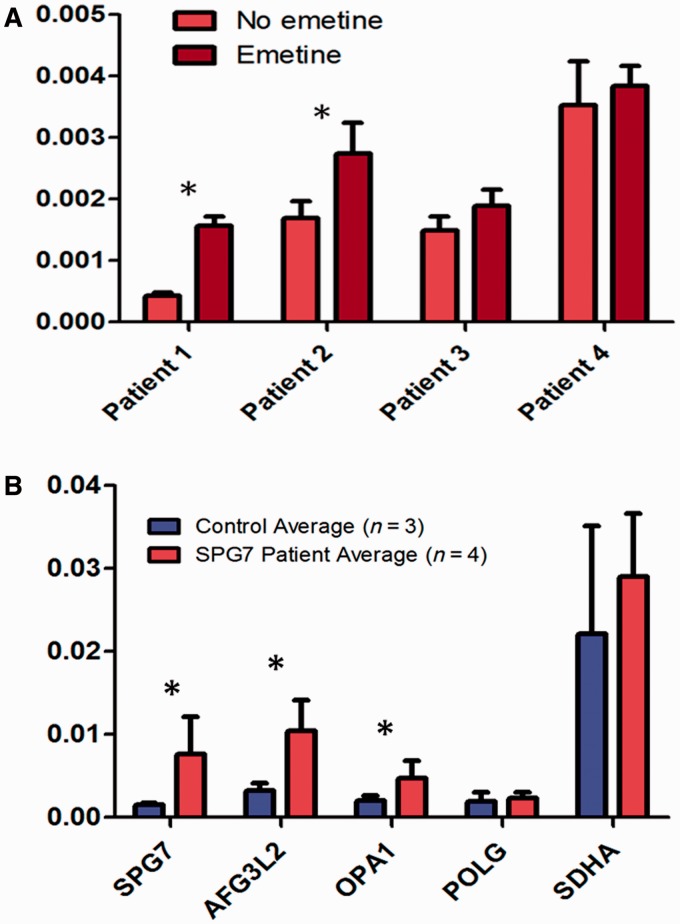
Transcript level measurement with reverse transcription quantitative PCR. (A) SPG7 transcript analysis in Patients 1–4, using RNA from cultured fibroblasts. For Patients 1–3 who have one or more nonsense mutations in SPG7, treatment of fibroblasts with emetine (dark bars) (an inhibitor of nonsense-mediated messenger RNA decay) compared with normal conditions (light bars), resulted in significantly increased SPG7 messenger RNA in Patients 1 and 2 (*P < 0.05). Patient 4 who has 2 missense SPG7 mutations does not have alteration in SPG7 expression with emetine (nor do control; data not shown). (B) Transcript quantitation in complementary DNA derived from muscle, in Patients 1–4 (red bands), compared with three control muscle samples (blue bands). Levels of SPG7, AFG3L2, and OPA1 transcripts are elevated in patients compared with controls (*P < 0.02). Levels of POLG and SDHA did not differ significantly.